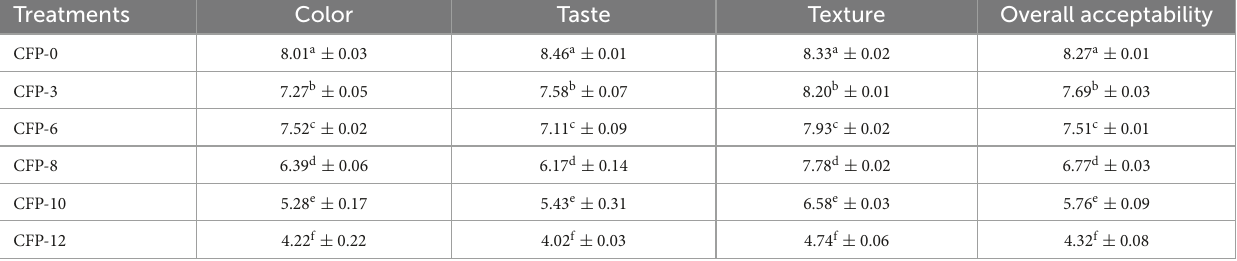
Different letters in each column show significant difference at p < 005. Each value is a mean of three replicates ± SD. CFP-0, Cookies fortified with 0 g PP powder (control); CFP-3, Cookies fortified with 3 g PP powder; CFP-6, Cookies fortified with 6 g PP powder; CFP-8, Cookies fortified with 8 g PP powder; CFP-10, Cookies fortified with 10 g PP powder; CFP-12, Cookies